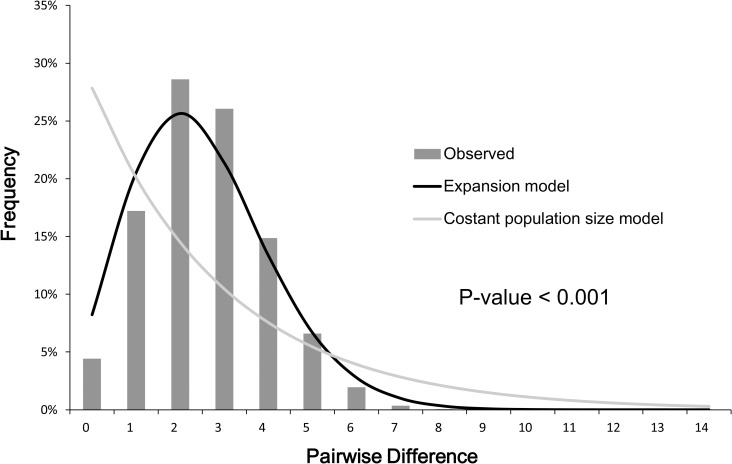
Mismatch distributions of concatenated mtDNA (1074 bp) of Rhinogobius gigas.The black line is the expected distribution calculated for the assumption of a demographically expanding population; gray line is the expected distribution under the constant population model; gray bars indicate the observed frequencies of pairwise differences of nucleotides among haplotypes.